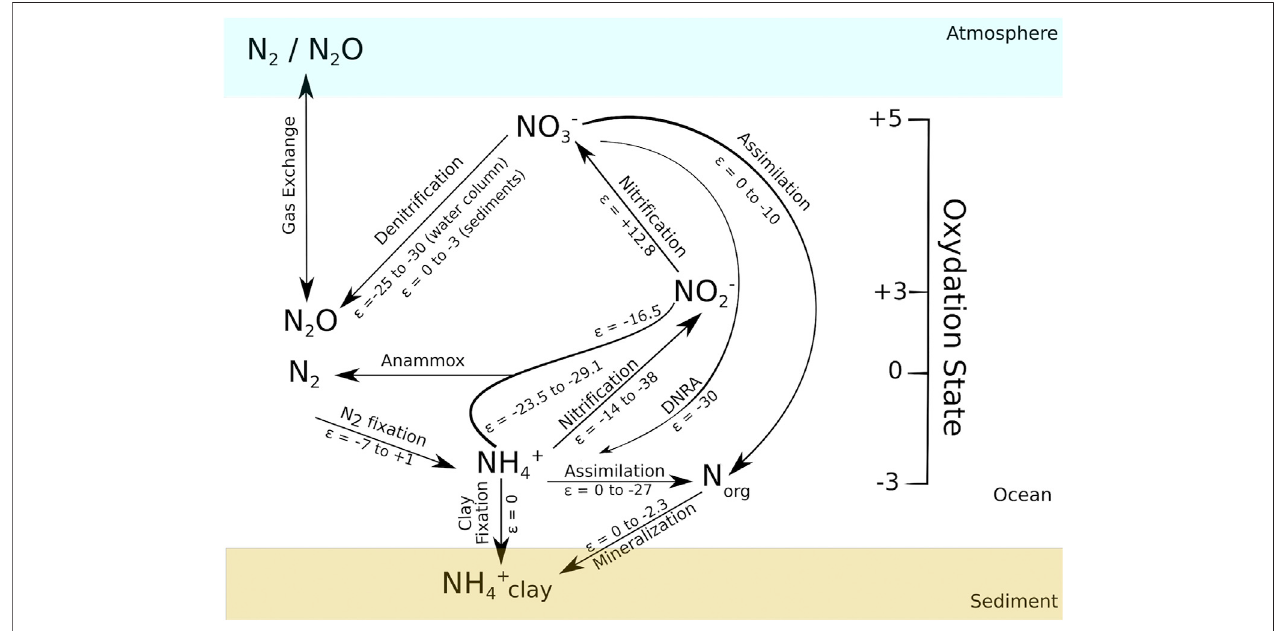
FIGURE 1 | Schematic diagram of the modern marine nitrogen cycle. Oxidation state of nitrogen species is shown on the vertical axis going from − 3 (NH 4+ ) to +5 (NO 3 − ). Nitrogen isotopic fractionation of the pathways of the N-cycle are detailed in the text and are expressed in ‰ . Modi fi ed after Ader et al. (2016).